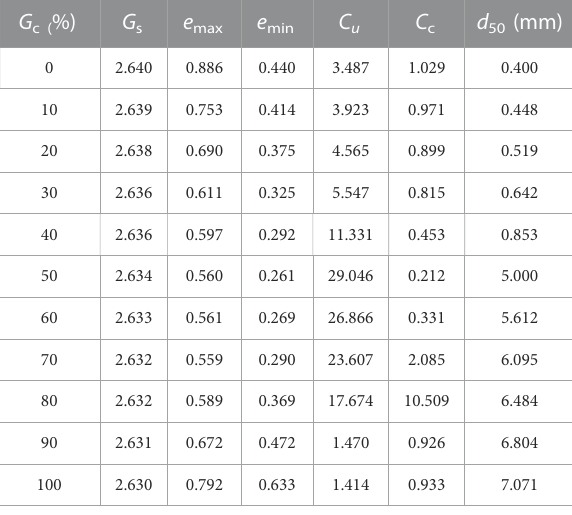
Table 1. The mixtures ’ particle size distribution curves and basic